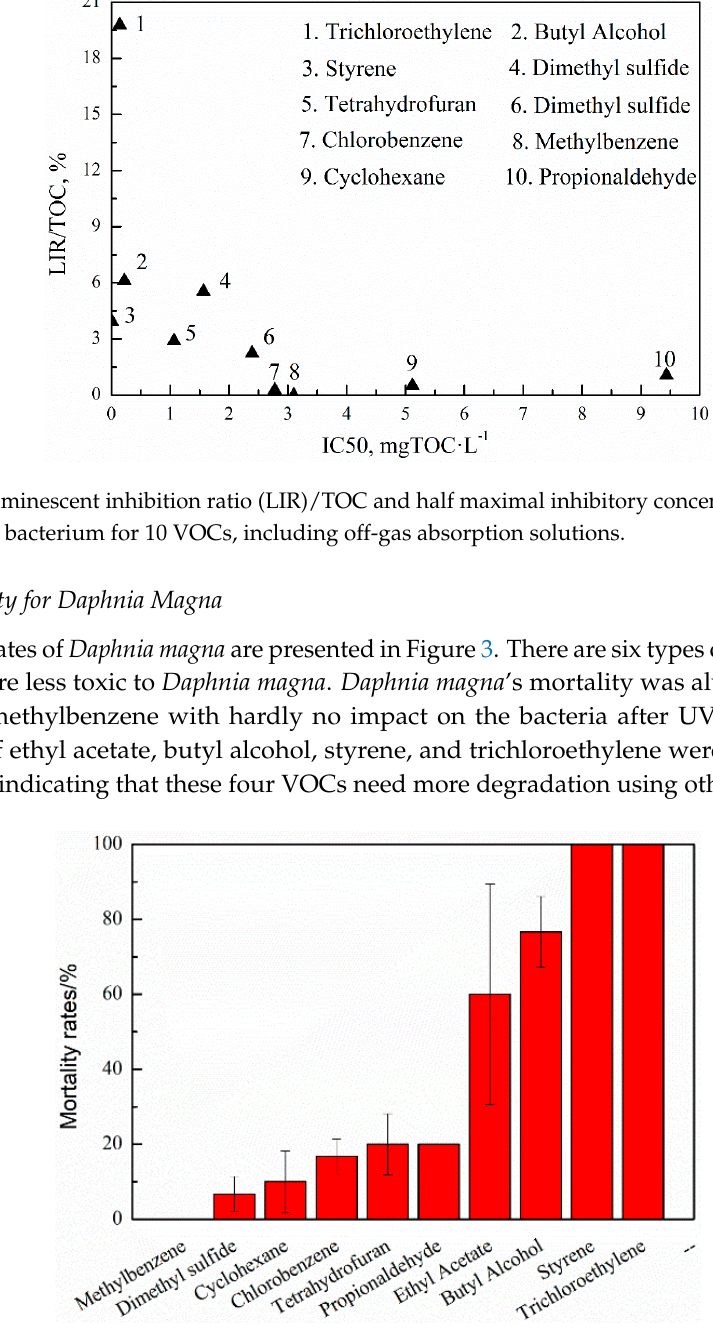
Figure 3. Mortality rates of Daphnia magna for 10 VOCs.